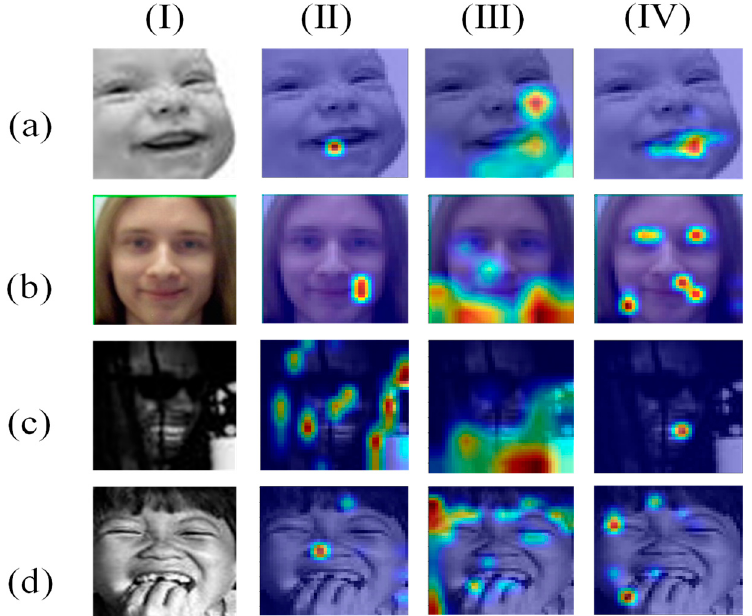
Figure 9. Attention visualization. Where ( a – d ) are pictures randomly obtained from the dataset, column (II) is the visualization result of adding ACW, column (III) is the visualization of adding the ASA module, and column (IV) is the visualization result of the network MAWNet proposed in this paper.